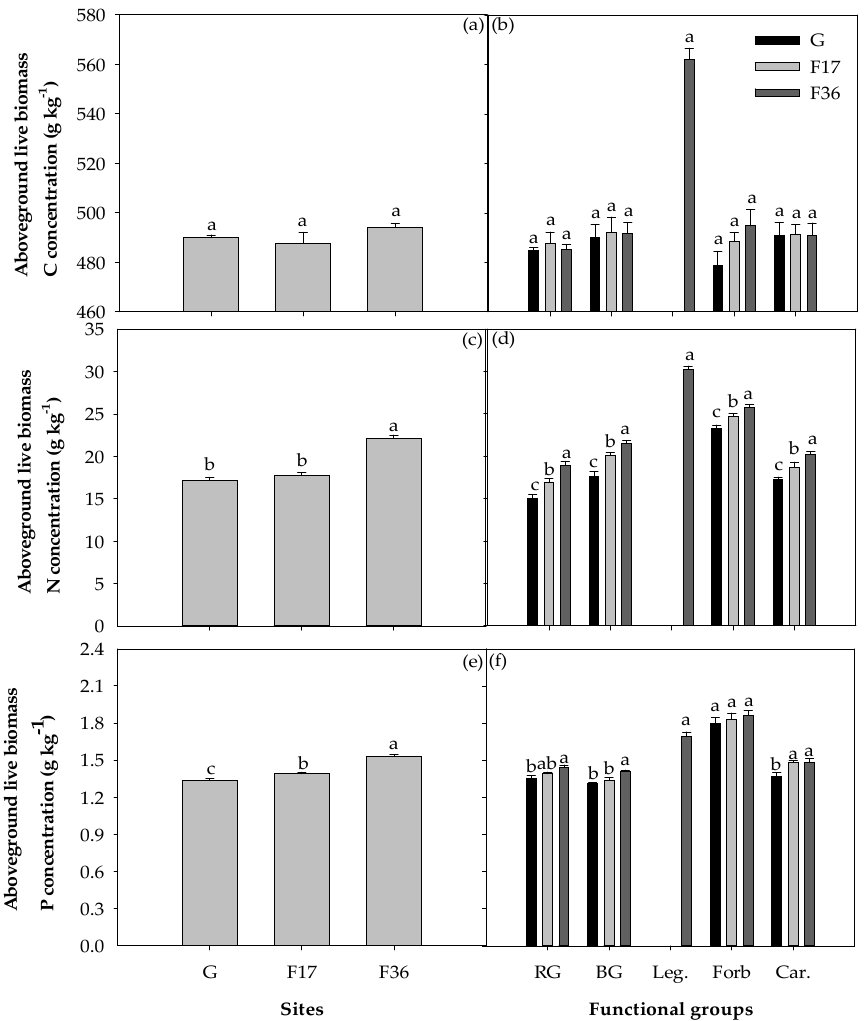
Figure 3. Variations in ( a ) aboveground live biomass C concentration, ( b ) aboveground live biomass C concentration of rhizome grass (RG), bunchgrass (BG), legume (Leg.), forb (Forb) and carex (Car.), ( c ) aboveground live biomass N concentration, ( d ) aboveground live biomass N concentration of five plant functional groups, ( e ) aboveground live biomass P concentration, ( f ) aboveground live biomass P concentration for five plant functional groups among free grazing (G), 17 (F17) and 36 years of fencing (F36) treatments. The values (mean ± SE) are means of five blocks; the same letters above the bars indicate no significant difference at the 0.05 level.